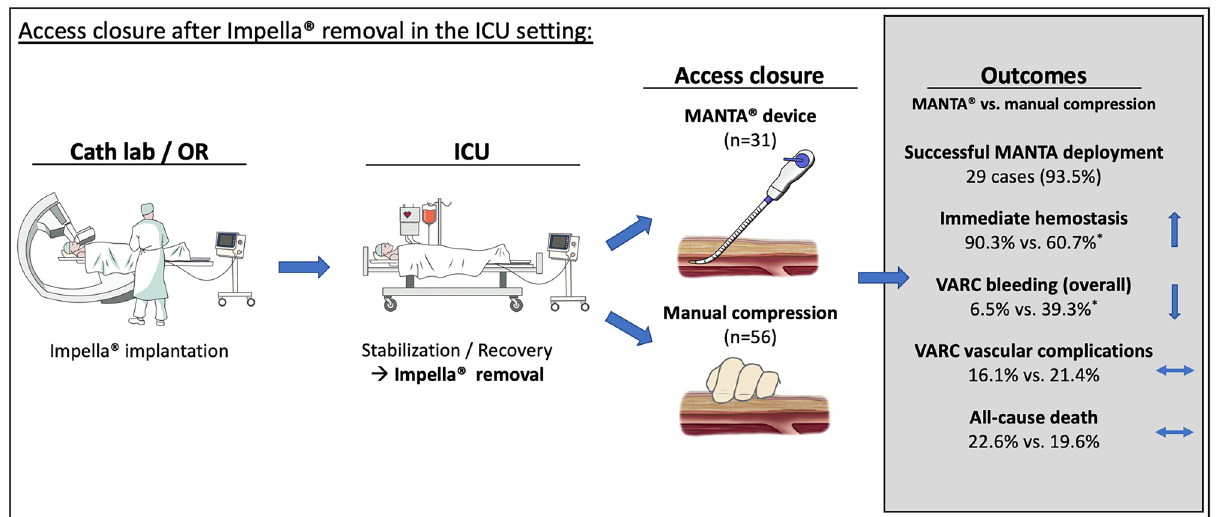
Figure 2. Access closure after Impella removal in the ICU setting. CU, intensive care unit; OR, operating room. *Indicates a statistically significant difference (p <